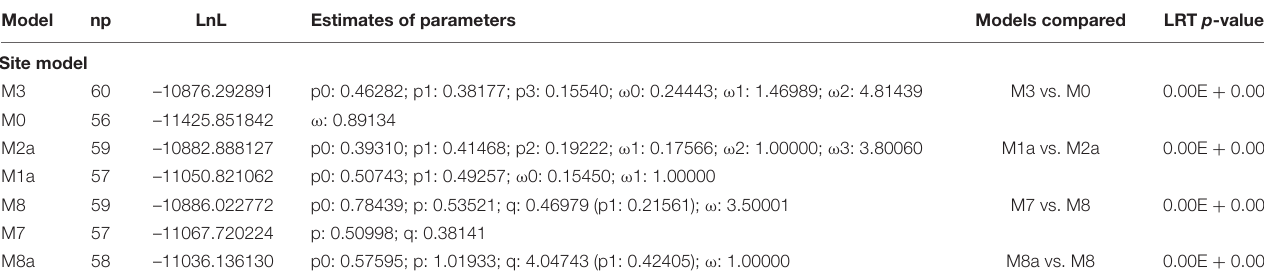
TABLE 2 | Positive selection analysis using site model on 113 lepidopteran AOXs and XDHs sequences.